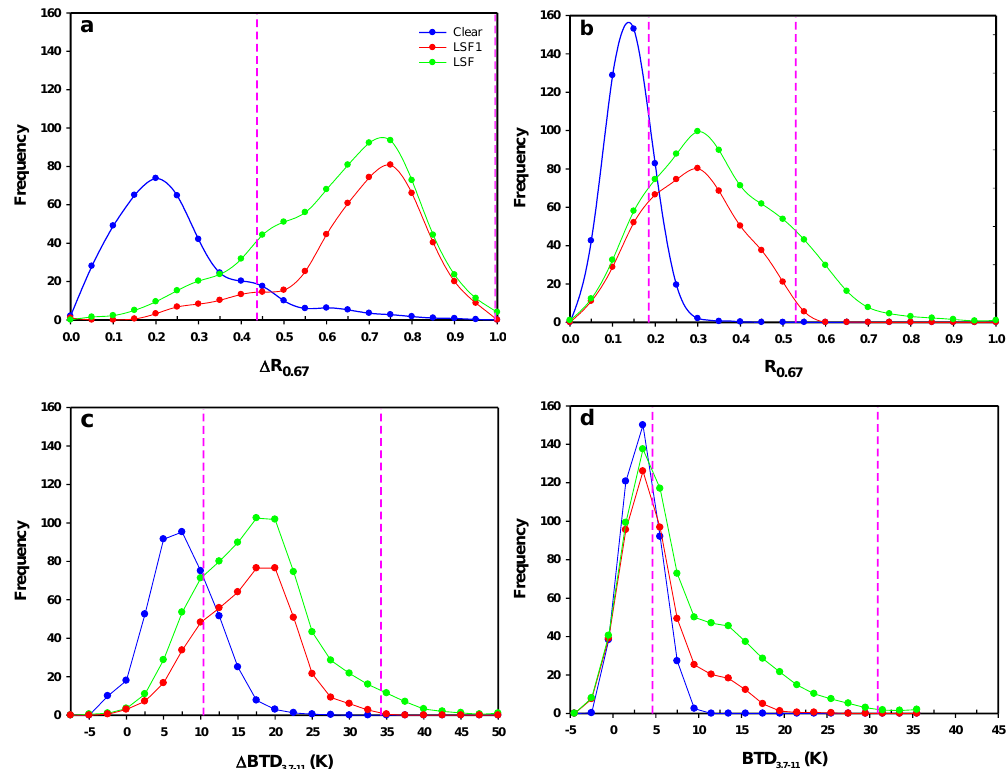
Figure 6. Frequency distributions of total LSF (green), LSF1 (red), and clear-sky (blue) with respect to ( a ) ∆ R 0.67 , ( b ) R 0.67 , ( c ) ∆ BTD 3.7-11 , and ( d ) BTD 3.7-11 . The pink dotted lines indicate the optimum threshold values that can be used for LSF detection when FAR ≤ 0.15. The ground-based observations of clear-sky and fog were used for the distributions, and the fog data were categorized into LSF1 and LSF highclouds with the help of satellite-observed criteria. Total LSF means the summation of LSF1 and LSF highclouds . Note that the upper limit (pink dotted line) is not needed to separate clear cases from fog, but is included to separate out optically thick convective clouds.